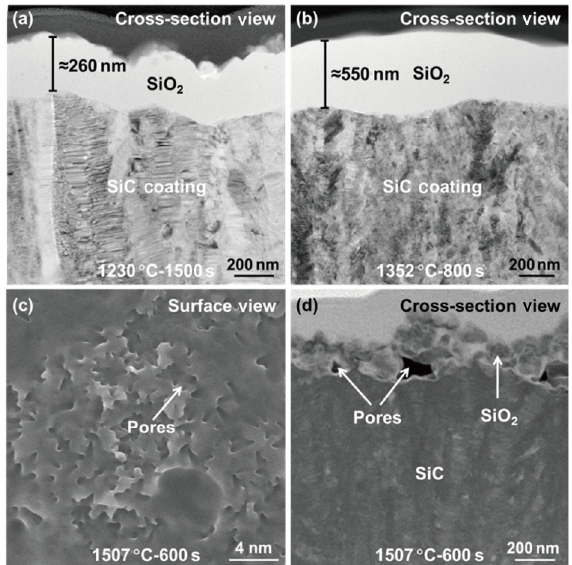
Fig. 6 Microstructures of SiO 2 layers formed at ~5 kPa: (a) ~1230 ℃ for 1500 s, (b) ~1352 ℃ for 800 s, and (c, d) ~1507 ℃ for 600